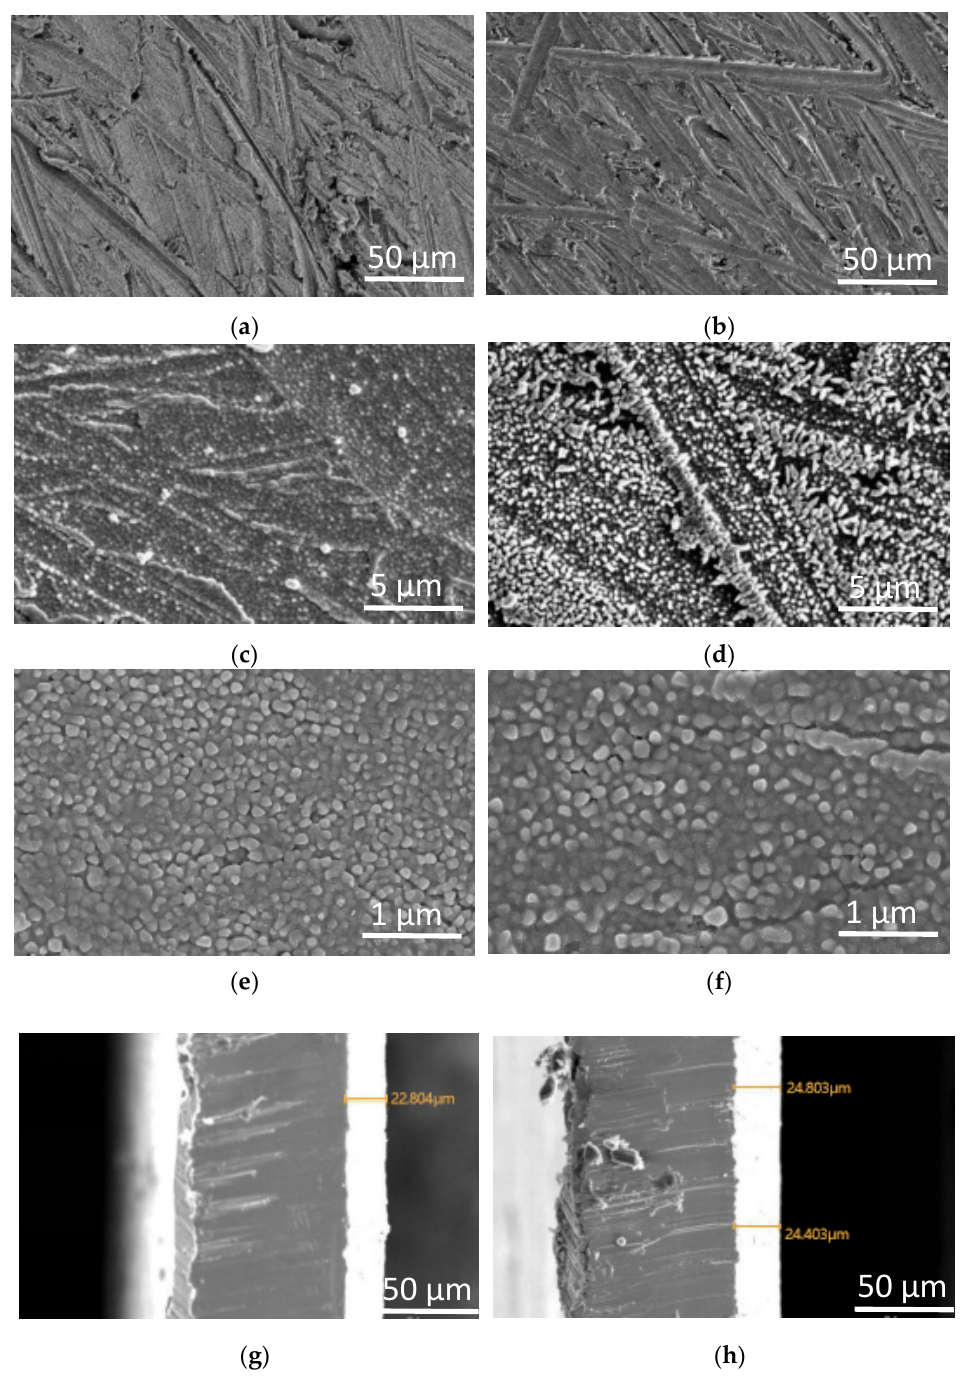
Figure 1. SEM image of the surfaces and sections of the tin plating layer ( a , c , e , g ) containing cerium nitrate; ( b , d , f , h ) not containing cerium nitrate.